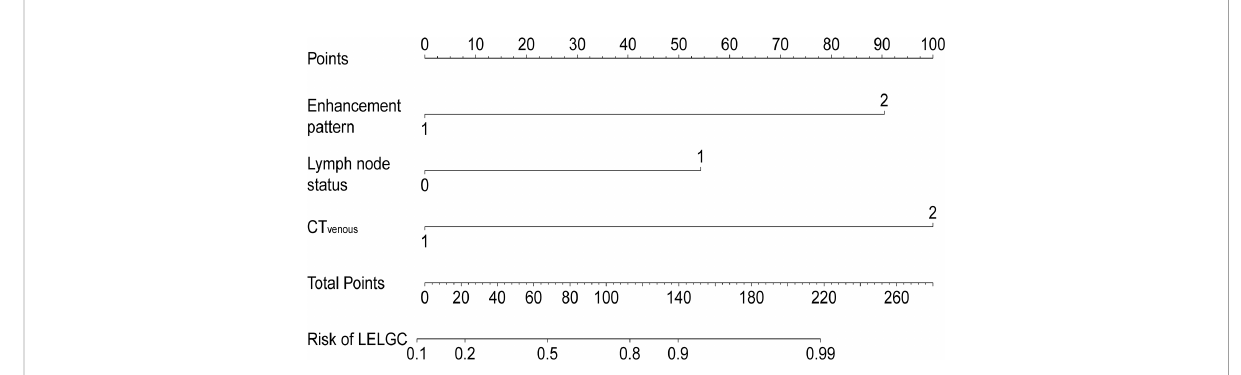
FIGURE 5 Nomogram for predicting lymphoepithelioma-like gastric carcinoma (LELGC). The CT venous , CT-de fi ned lymph node status, and enhancement pattern were incorporated into nomogram fi